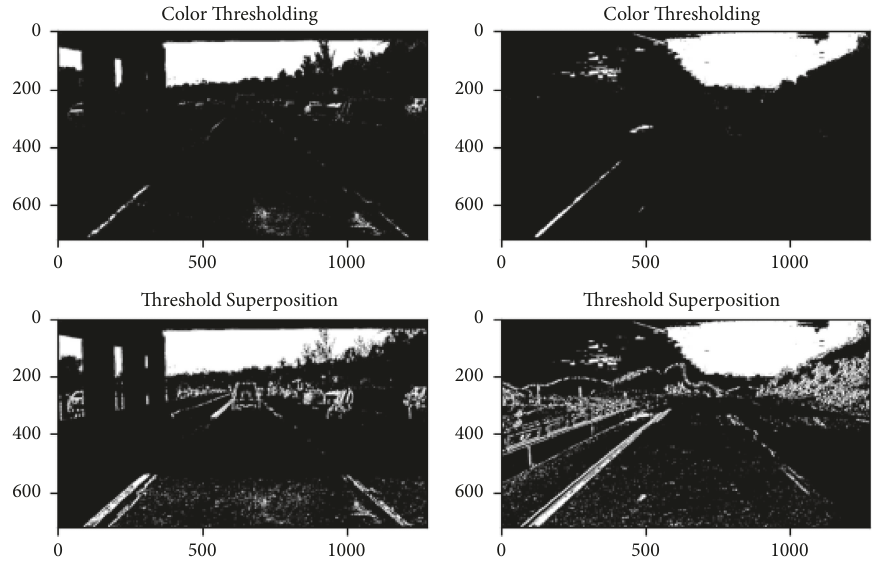
Figure 7: Results of threshold color and